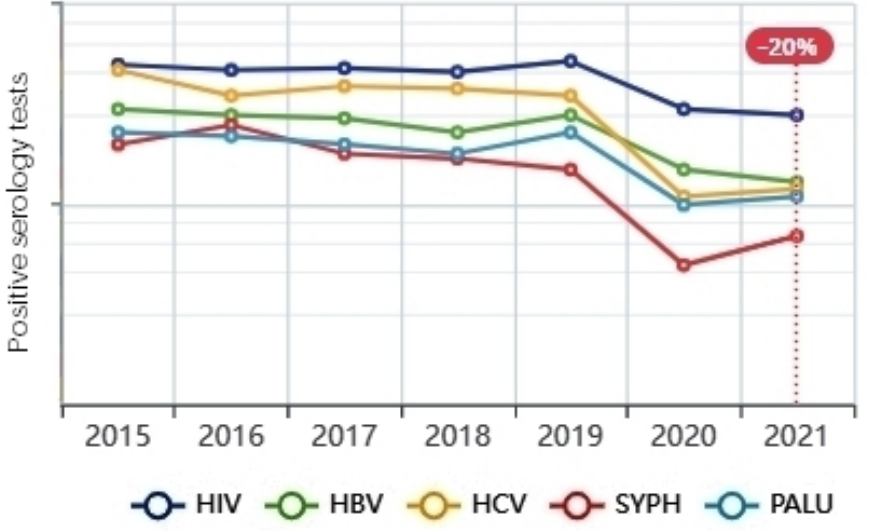
Figure 11. Positive infectious